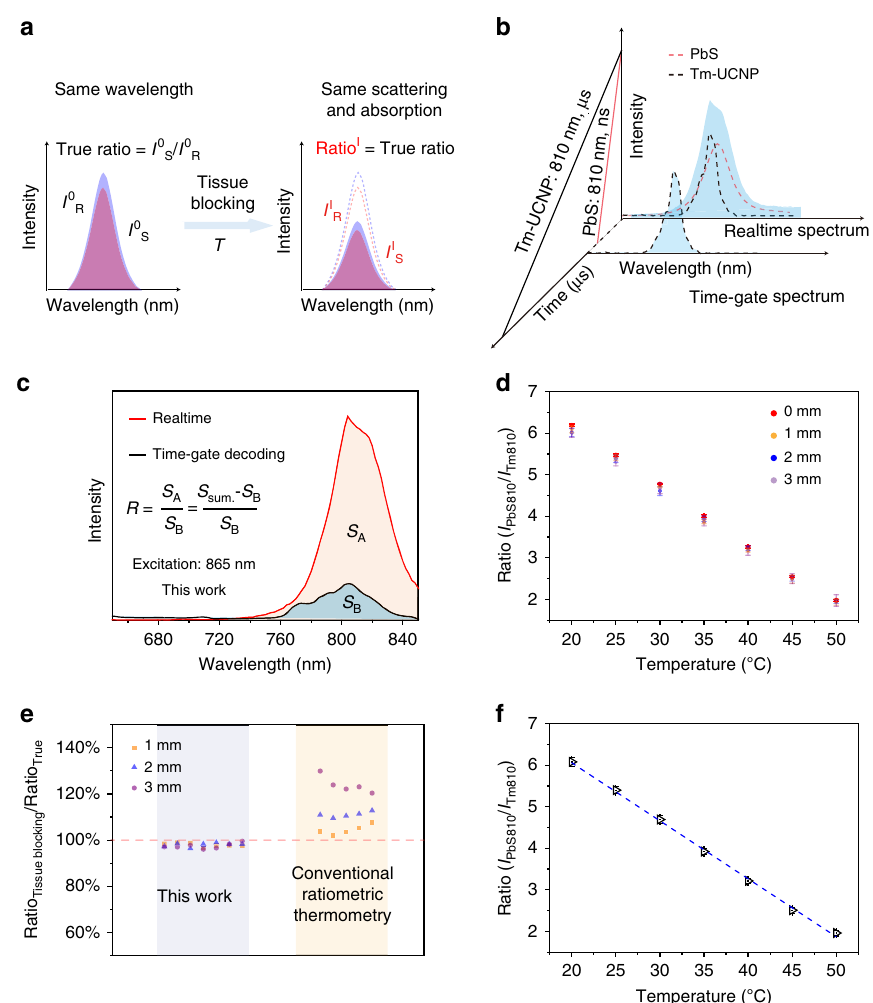
Fig. 4 Evaluation of temperature monitoring ability of UCL-NCs. a Schematic illustration of conventional ratiometric thermometry with the same wavelength emission. b Schematic diagram of UCL signals separation via time-resolved decoding. c UCL emission signals decoding of UCL-NCs using time- resolved spectrometer. d The same wavelength ratio of I PbS to I Tm obtained using time-resolved spectrometry at different temperatures and blocking with pork tissue slice of various thickness. Data and error bars, de fi ned as s.d., were based on three measurements with an excitation of 865 nm laser on spectrometry. e Ratio values deviation due to blocking with pork tissue slice of different thickness compared with ratio signals measured without pork tissue slice blocking using the same wavelength or conventional ratiometric thermometry. f A plot of I PbS810 / I Tm810 versus T to calibrate the temperature. Average values of I PbS810 /I Tm810 under different temperatures were obtained to fi t the calibration curve based on the spectra with blocking due to pork tissue slice of different thickness. Error bars were de fi ned as s.d. Source data are provided as a Source Data fi